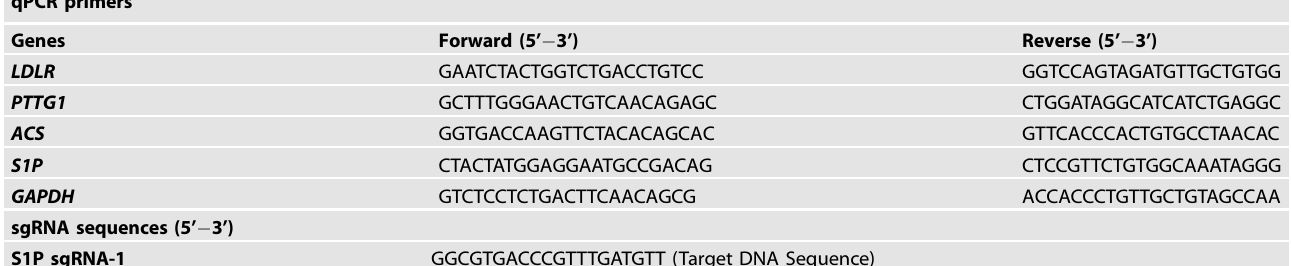
Table 2. Sequences utilized in this